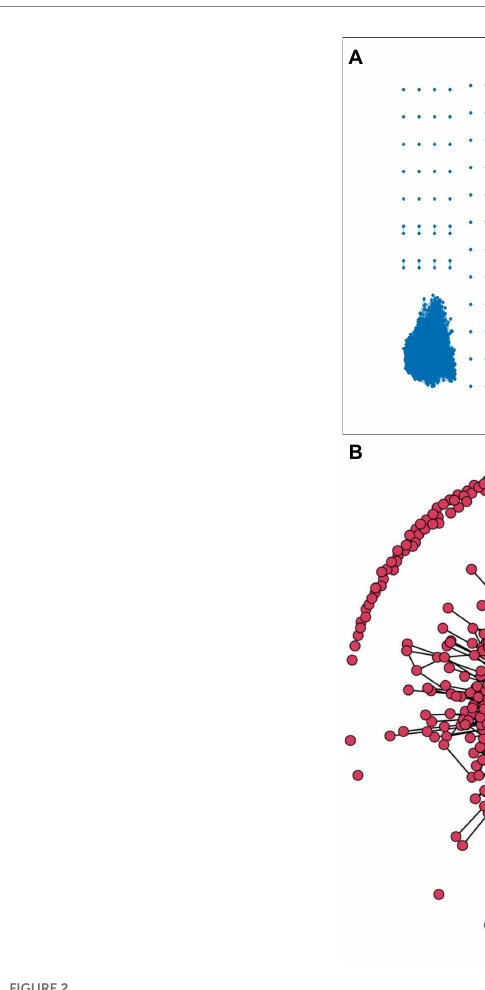
FIGURE 2 The inferred colleagues’ social network for all participants (A) Sparse and (B)